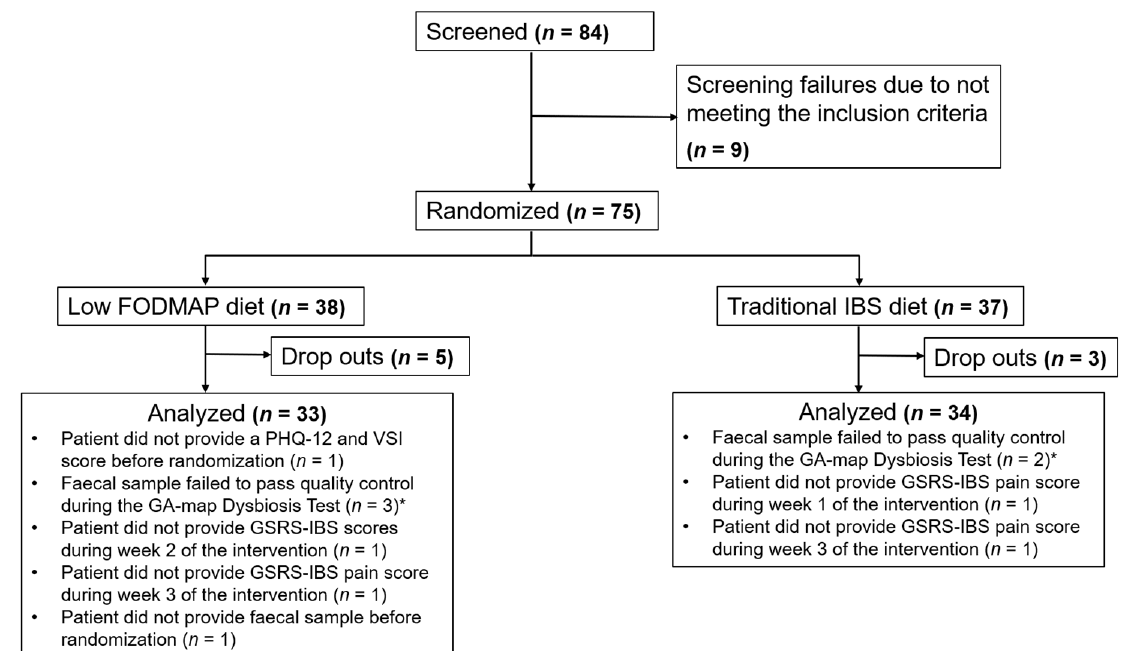
Figure 1. Flow chart indicating the number of patients included in each study phase, for details see text. Fermentable oligo-, di-, monosaccharides, and polyols, FODMAP; Patient Health Questionnaire-12, PHQ-12; Visceral Sensitivity Index, VSI; Gastrointestinal Symptom Rating Scale-Irritable Bowel Syndrome, GSRS-IBS. Table 1. Clinical characteristics of the two treatment arms at baseline *.